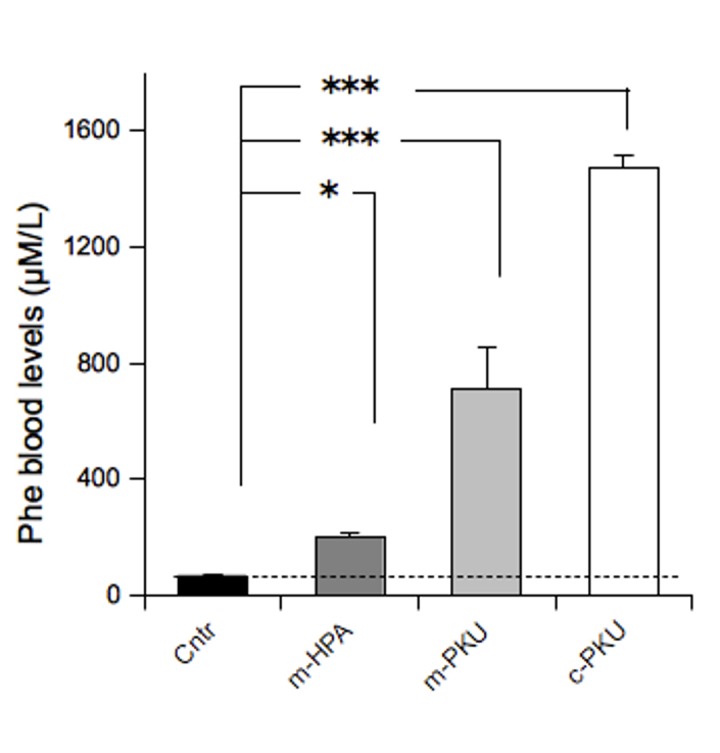
Blood levels of PHE in different forms of HPA.Values are expressed as means + S.E.M. N=6 for group.*,*** p<0.05, 0.001 from Cntr mice.